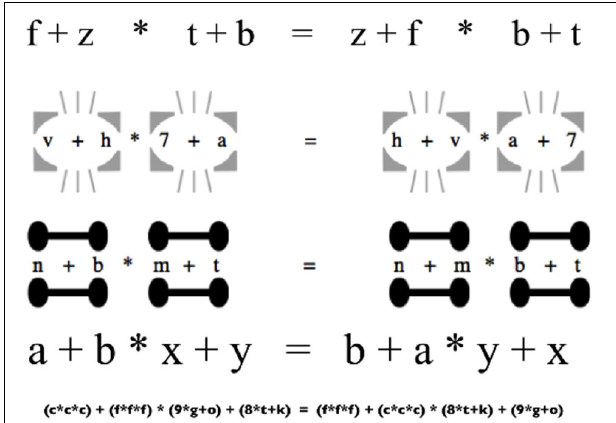
FIGURE 1 | Some of the formats employed by Landy and Goldstone (2007a). Visual cues such as added spacing, lines, and circles influence the application of perceptual grouping mechanisms, influencing the capacity for symbolic